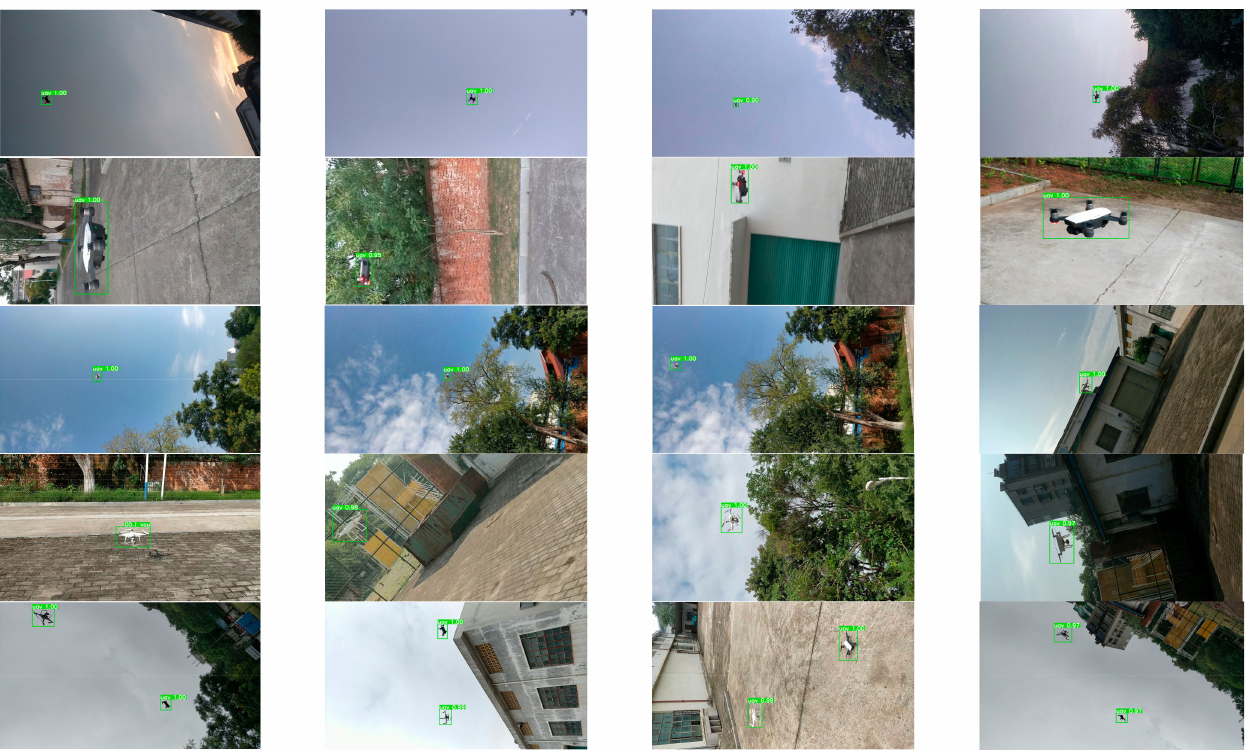
Figure 11. UAV detection results in different